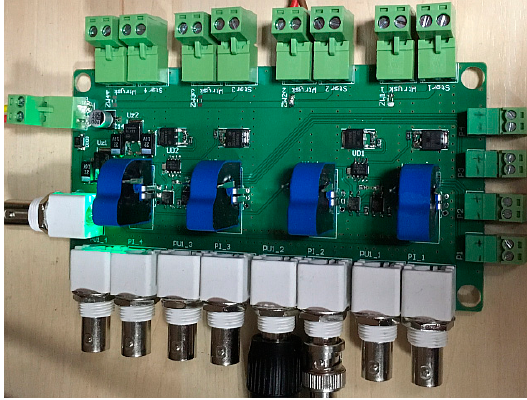
Figure 3. Control and measuring module.